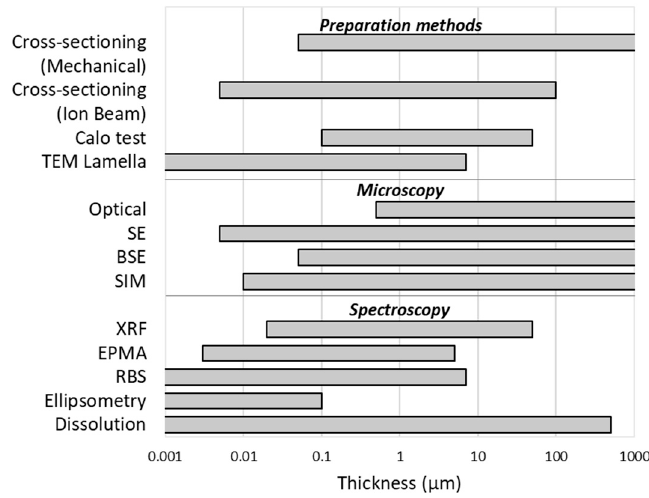
Figure 16. Range of thicknesses that a metal sample must have to be properly analyzed for each technique.